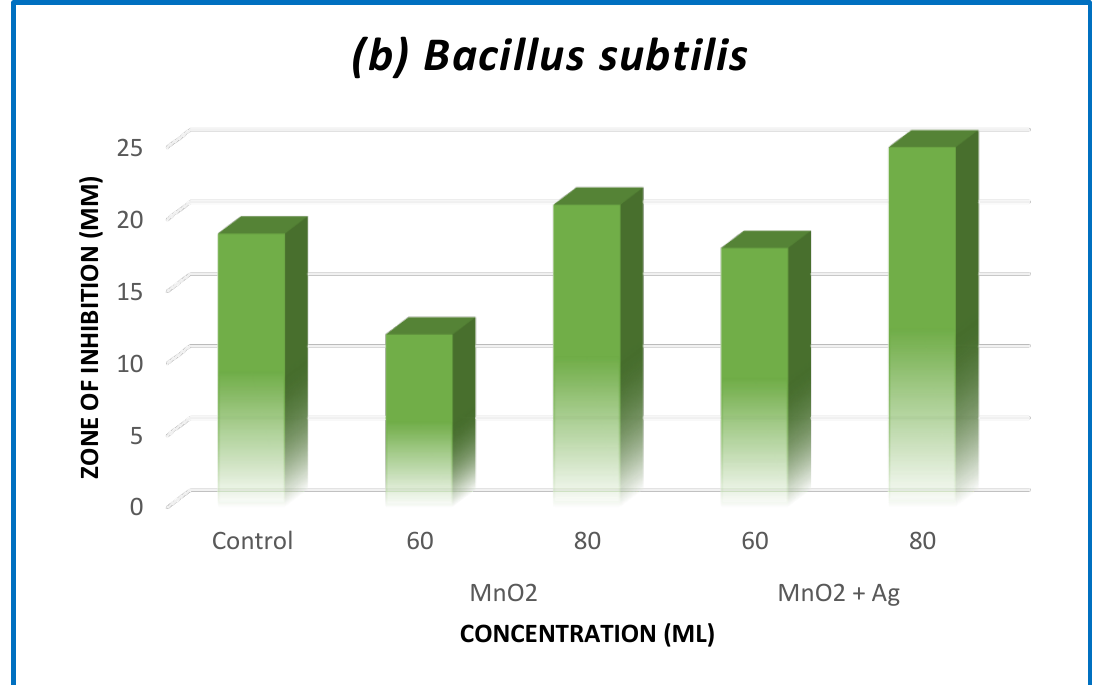
Figure 11. Zone of inhibition of MnO 2 doped with Ag nanoparticles against ( a ) Gram-negative ( Escherichia Coli ) bacteria and ( b ) Gram-positive strain ( Bacillus subtilis Figure 11. ( a , b ). Zone of inhibition of MnO 2 doped with Ag nanoparticles against (a) Gram-negative ( Escherichia Coli ) bacteria and (b) Gram-positive strain ( Bacillus subtilis ).